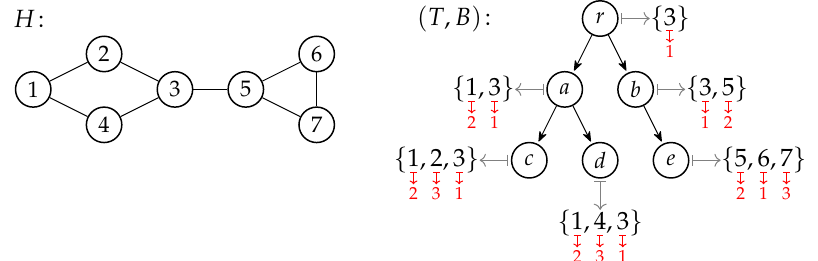
Figure 1. An example graph H together with a tree decomposition for it, consisting of the tree T and the bag function B indicated using the small gray mapping arrows. A consistent numbering p is indicated in